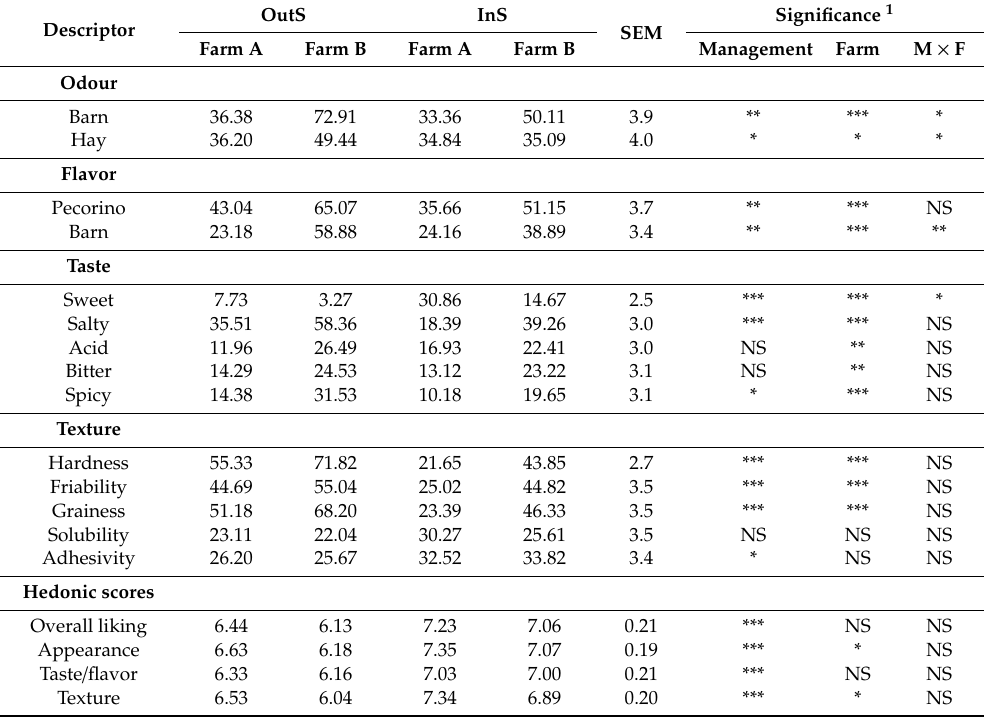
Table 6. Sensory profile, as assessed by a 12-member trained panel, and hedonic scores, as scored by a 100-member untrained consumer panel, of Bagnolese pecorino cheese a ff ected by the management system, the farms, and their interaction (LSM ±